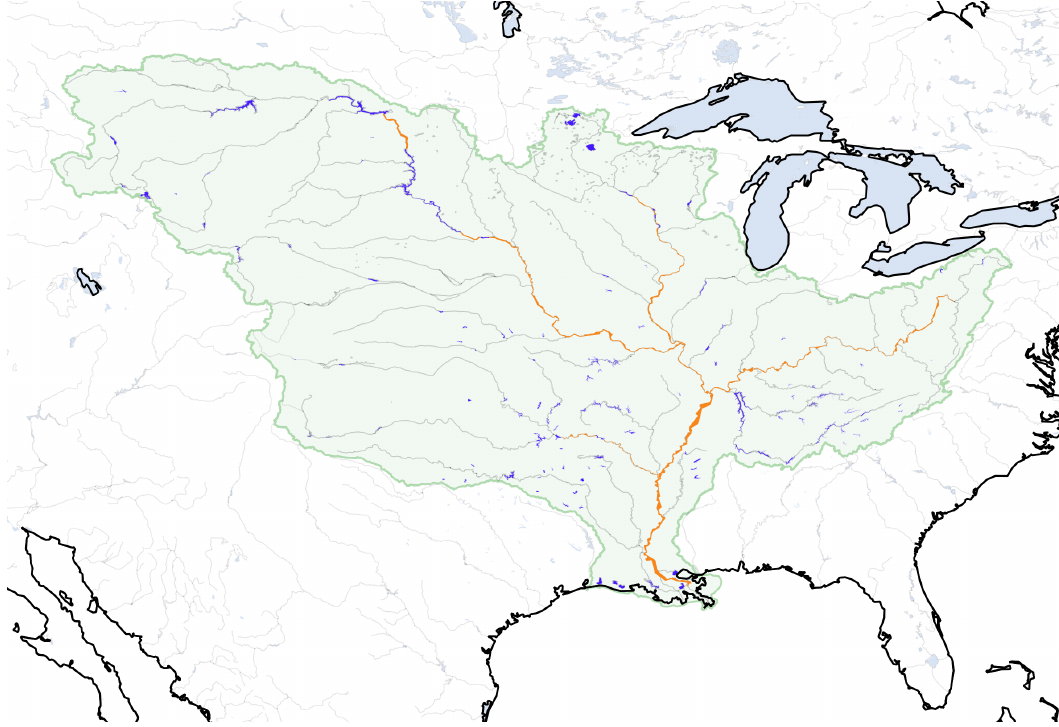
Figure 1. The Mississippi River Basin: Lakes and reservoirs that are implemented in WaterGAP are shown in blue, major rivers as grey lines. Orange: River sections that were removed manually (see Section